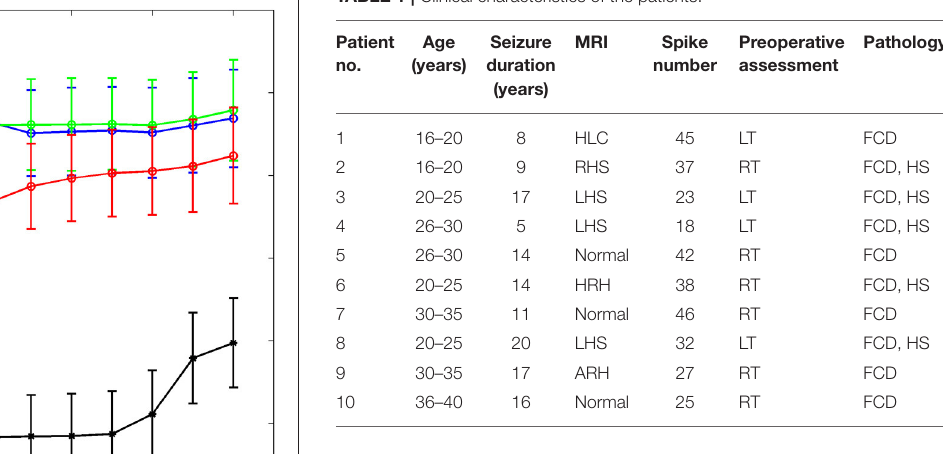
TABLE 1 | Clinical characteristics of the